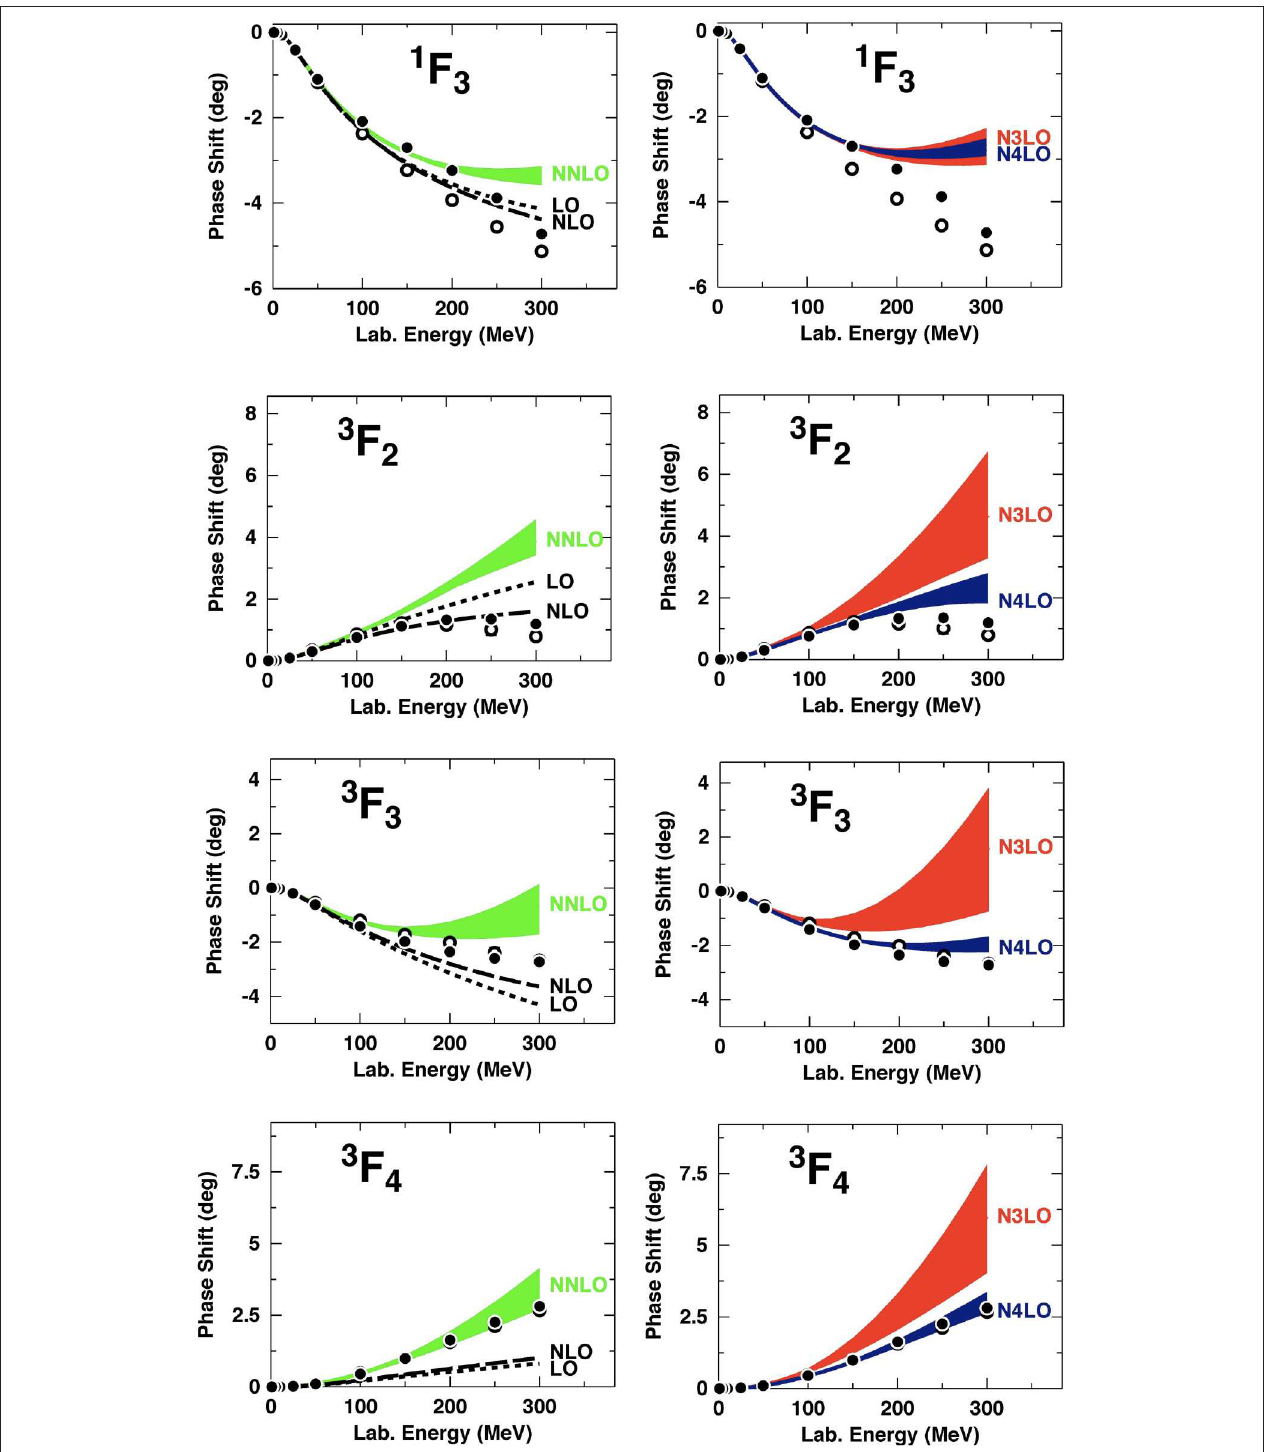
FIGURE 10 | Phase-shifts of neutron-proton scattering at various orders as denoted. The shaded bands show the sensitivity of the contributions to the SFR cut-off ˜ 3 which is varied over the range 0.7–1.5 GeV. Filled and open circles as in Figure 9 . Reprinted figure with permission from Entem et al. [46], copyright (2015) by the American Physical